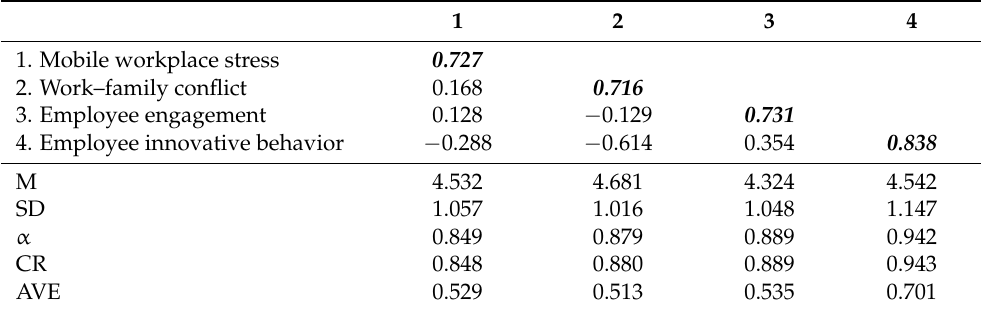
Table 3. Correlations, means, standard deviations, Cronbach’s alpha, composite reliability, and average variance extracted.